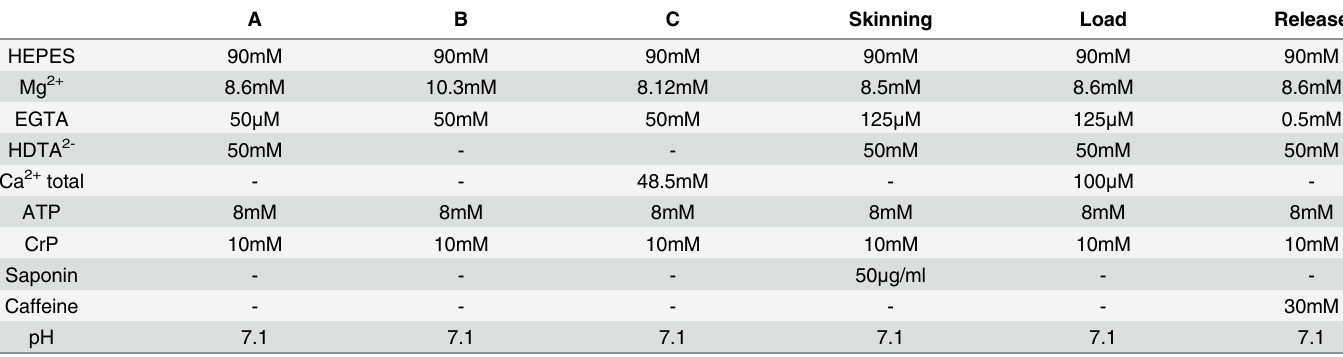
Table 1. Intracellular solutions used for skinned bundle